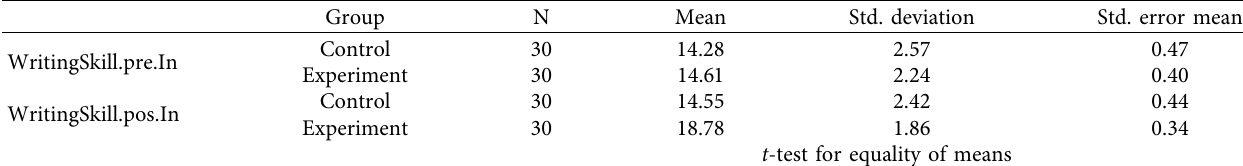
Table 15: Group statistics.